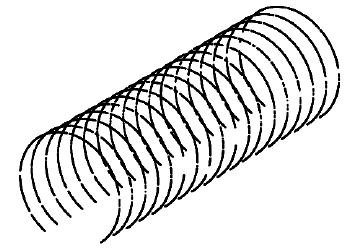
Figure 10 Denoisig result of the final sectional point sets